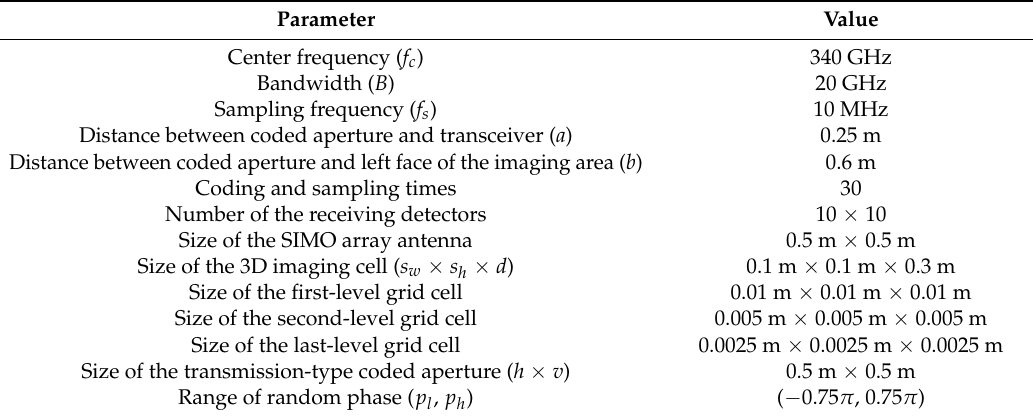
Table 1. Primary parameters used in the